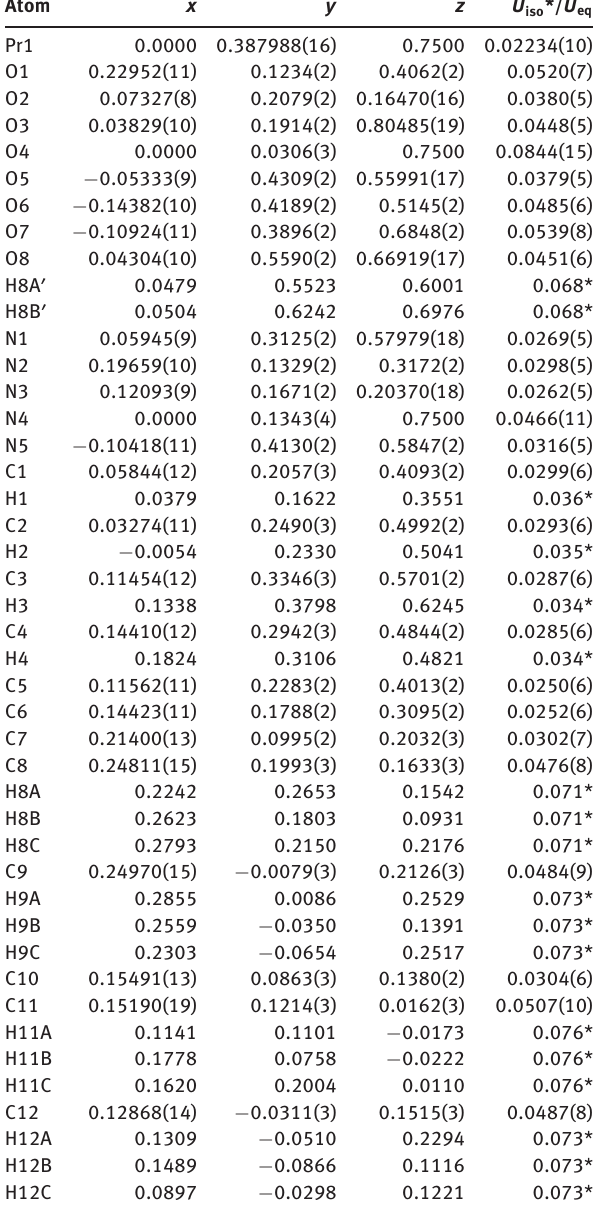
Table 2: Fractional atomic coordinates and isotropic or equivalent isotropic displacement parameters (Å 2